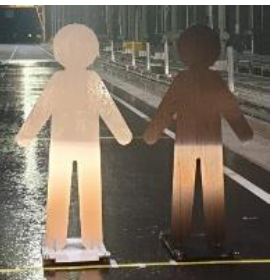
Figure 5. Pedestrian type reflectors as pedestrian targets: Pedestrian target design (height 175 cm, width 92 cm, with four wheels attached below for convenience of movement.